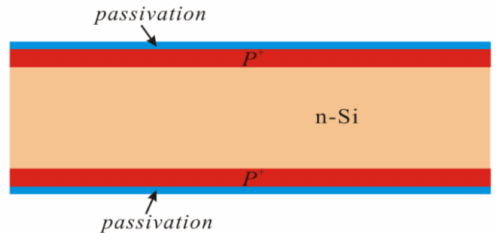
Figure 6. Symmetric structure for passivation quality test.